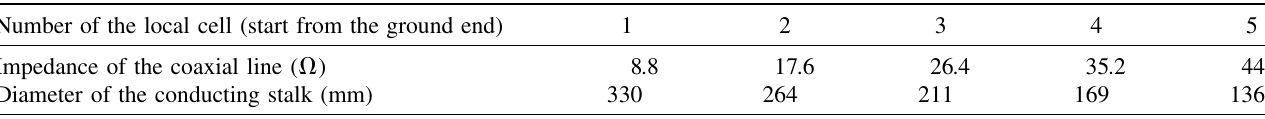
TABLE III. Size of the anode stalk and corresponding impedance of the coaxial